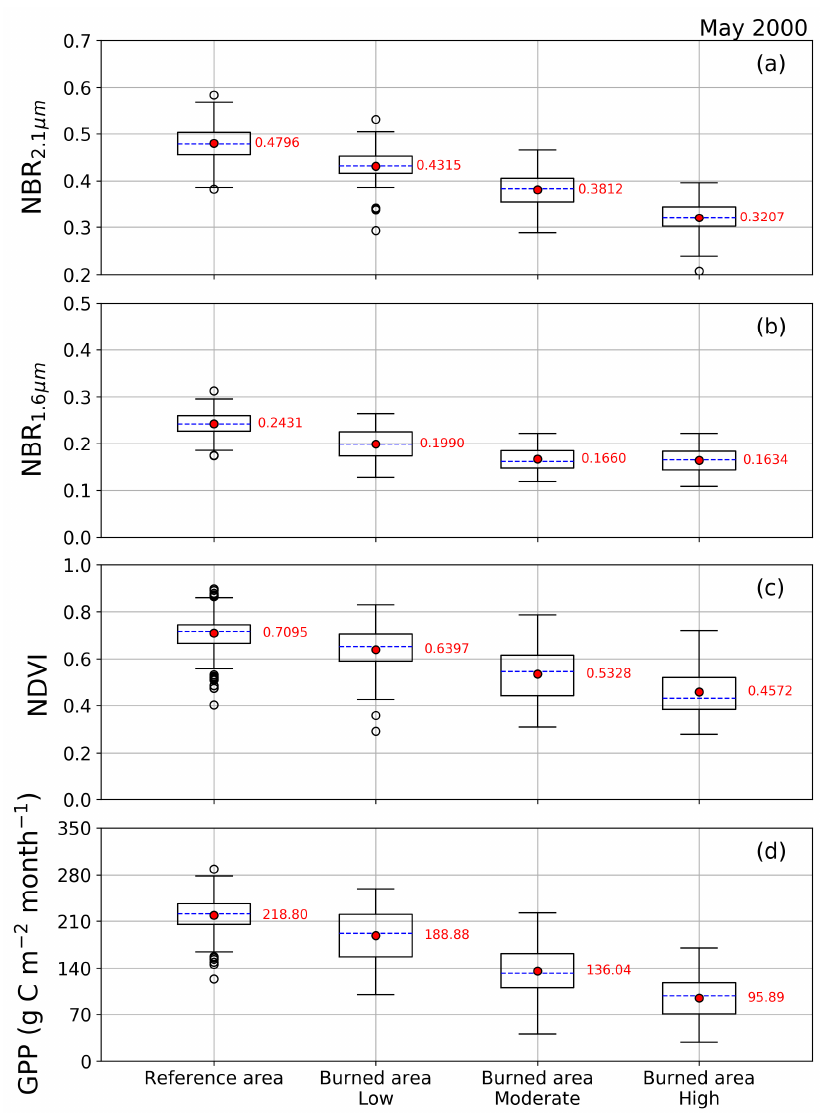
Figure 3. Vegetation indices and gross primary production (GPP) based on forest fire severity. Red circles indicate average values, and blue dash lines indicate median values: ( a ) NBR 2.1 ; ( b ) NBR 1.6 ; ( c ) NDVI; and ( d ) GPP.